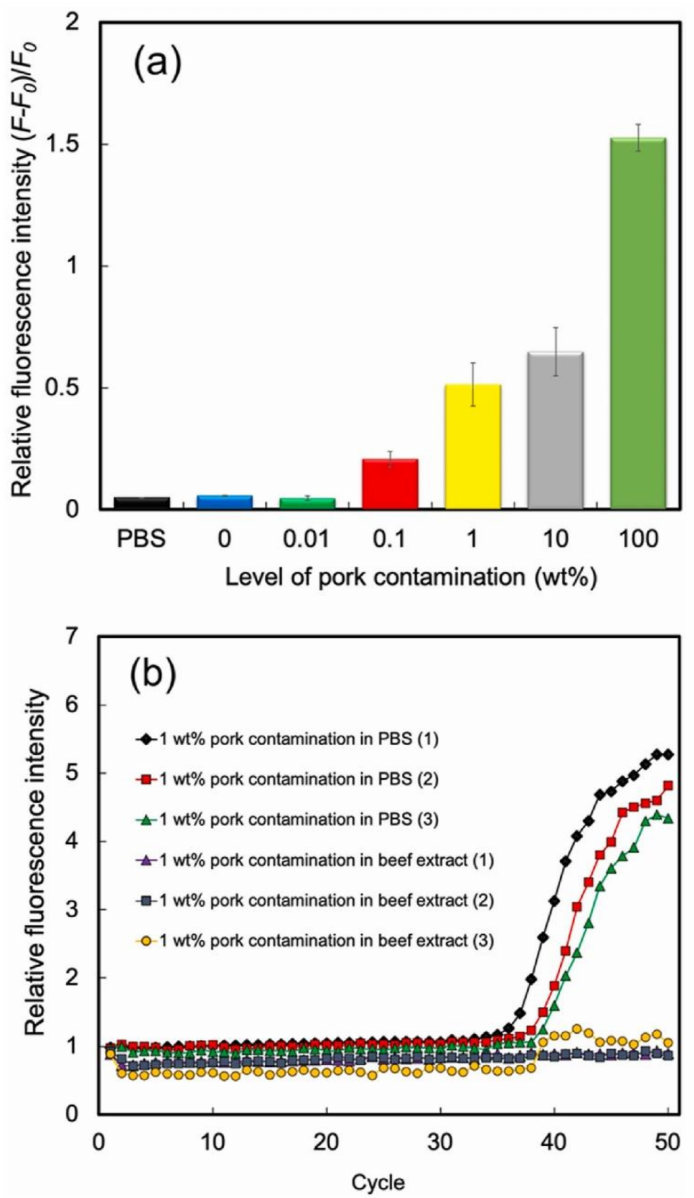
Figure 10. Sensor signal for pork contamination in beef extract samples (0–100 wt%), n = 3 ( a ). The real-time PCR results of 1 wt% pork contamination in PBS and beef extract samples, n = 3 ( b ); Reproduced with permission from [84], ©